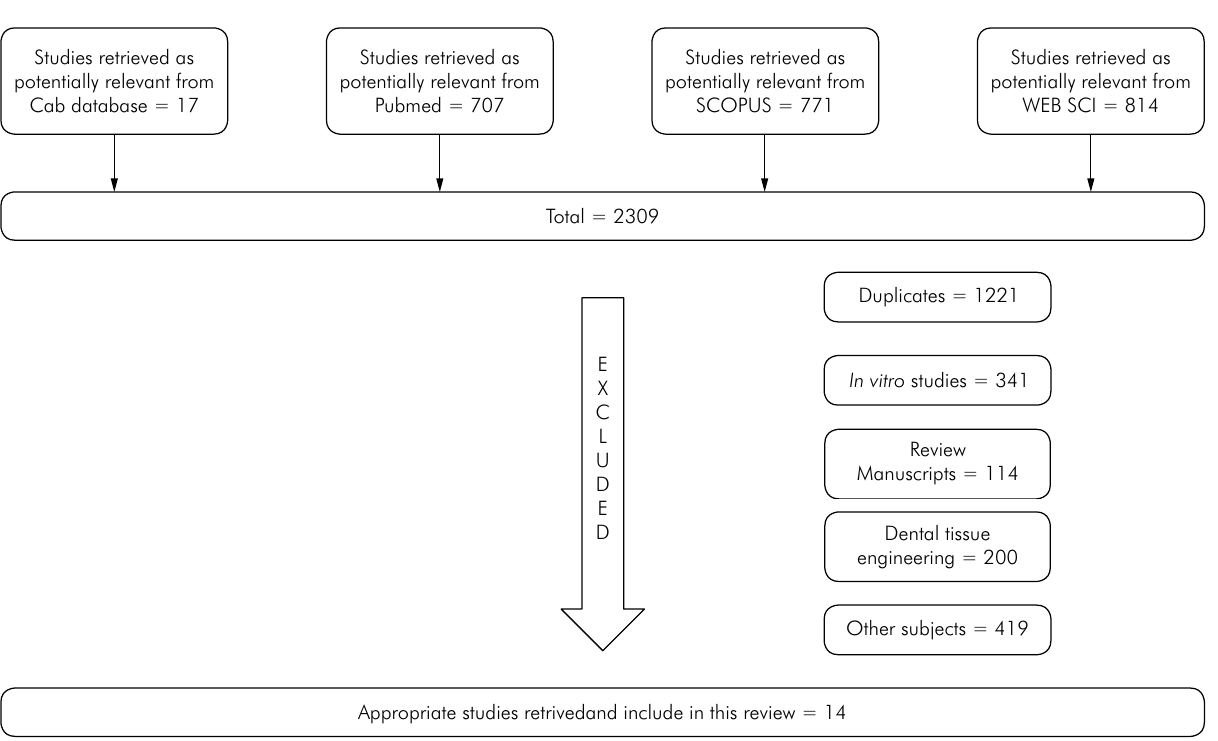
Figure 1. Flow diagram presenting the results of the literature search and the process used to select studies for the systematic review.